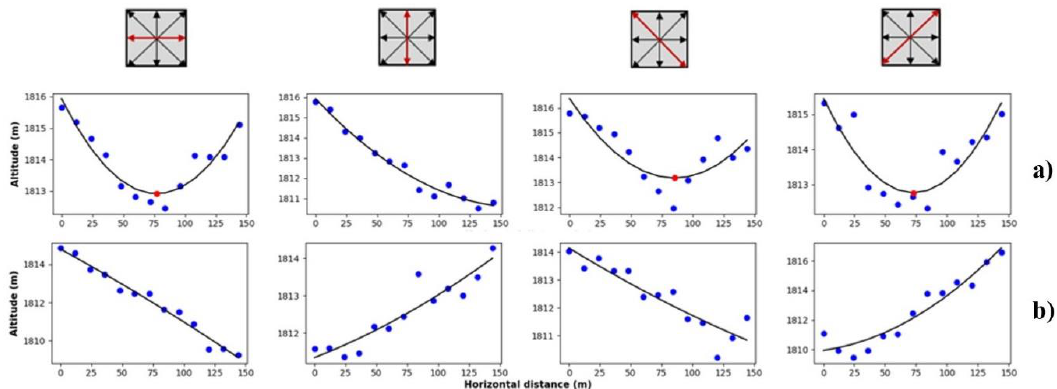
Figure 14. Details of the point heights (in blue dots) in the four profiles and the corresponding adjusted functions (black lines) with the corresponding relative minimums (red dots) when detected. The row above ( a ) corresponds to the Square 1 in Figure 13 and the row below ( b ) corresponds to Square